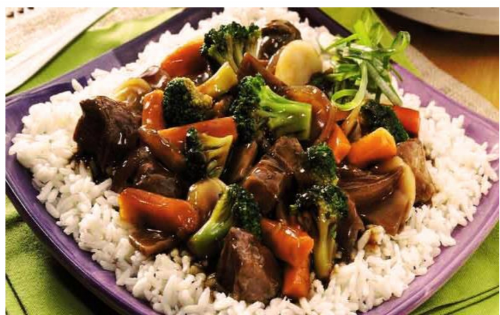
Figure 2. Chop suey. Source: Cocinate el mundo. Chop Suey, los secretos de esta gran receta oriental [25].